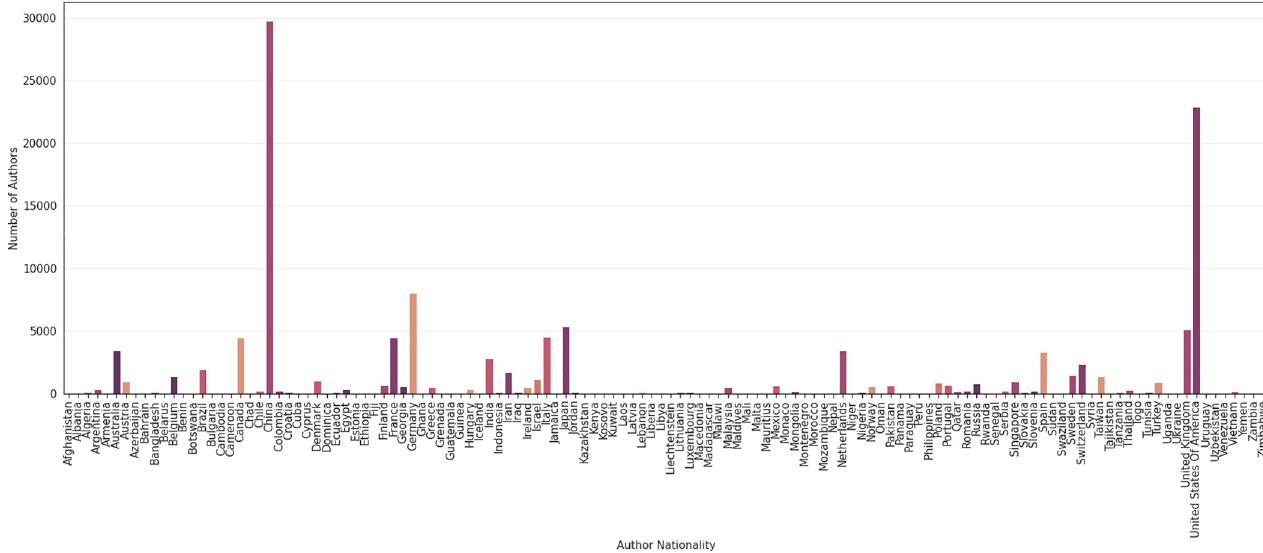
Fig 4. Distribution of overall author nationality in AI in